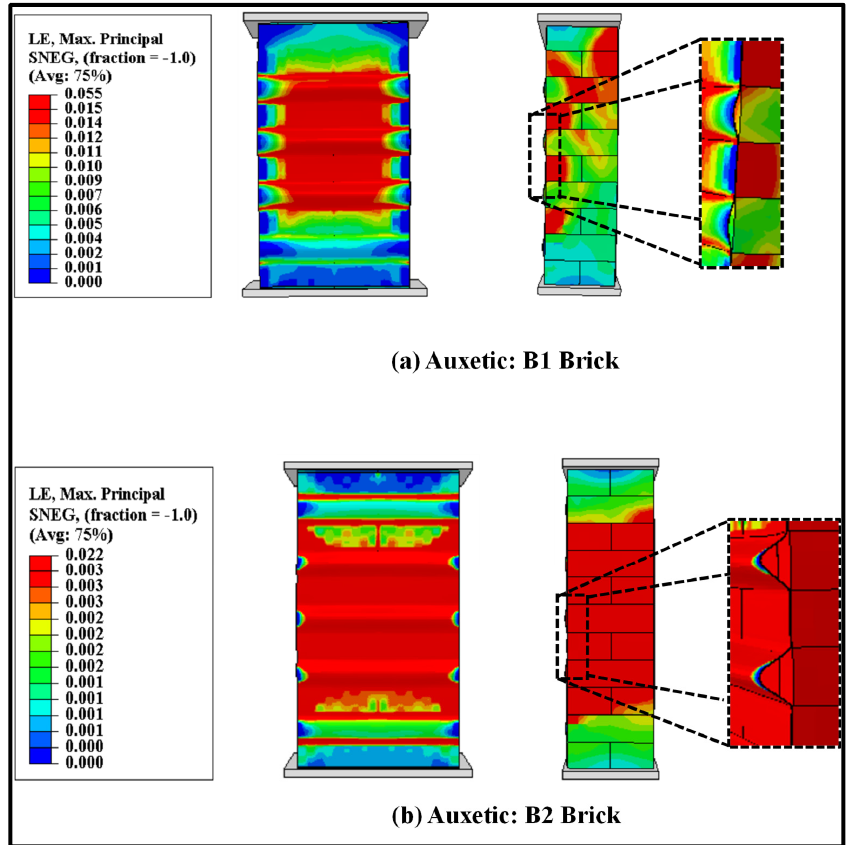
Figure 21. Numerically predicted damage on the surface of the auxetic fabric and masonry wallettes constructed of different brick types, ( a ) B1 and ( b ) B2, tested under cyclic compression loading. The stress-strain curves of the cyclically loaded auxetic fabric-strengthened wallettes A simplified illustration of the axial strain distribution with respect to time on the are presented in Figure 22. The cyclic hysteresis stress-strain curves predicted that the surfaces of the masonry wallettes and the auxetic fabric sheet is plotted in Figure 23. The auxetic-strengthened masonry wallettes behaved in a softer and more ductile way than axial strain was plotted at mid-height of the wallettes. Figure 23a,b show that the strain the control and CFRP-strengthened masonry wallettes (presented in Figure 17). Addition- distribution on the surface of the auxetic fabric and at the masonry surface completely ally, as expected, the auxetic-strengthened masonry wallettes of B2 brick showed an early overlapped with each other, with variation in time. The plotted strain distribution time failure compared to the B1 brick wallettes, due to the brittle and stiff nature of the brick, history provides clear evidence of non-debonding at the interface between the auxetic as shown in Figure 22b. However, compared to CFRP-strengthened brickwork, the auxe- tic-strengthened masonry wallettes showed a significant improvement in terms of ductil- fabric and the masonry wallettes. However, comparing Figure 23a,b, the damage in the ity. It can be noted that there is an increase of 50% in compression strains from un- auxetic-strengthened masonry wallettes constructed of B2 brick occurred at lower strengthened to auxetic-strengthened wallettes of the B1 brick type, as shown in Figure 22a. In contrast, when compared with the CFRP-strengthened wallettes (presented in Fig- ure 17), the same compression strain showed a significant increase of about 80%. A similar observation of enhancement in compression strain was observed for the auxetic-strength- ened masonry wallettes of B2 brick types when compared to the corresponding un- strengthened masonry wallettes. Hence, to confirm the non-debonding characteristics of the auxetic fabric, an investigation was performed.